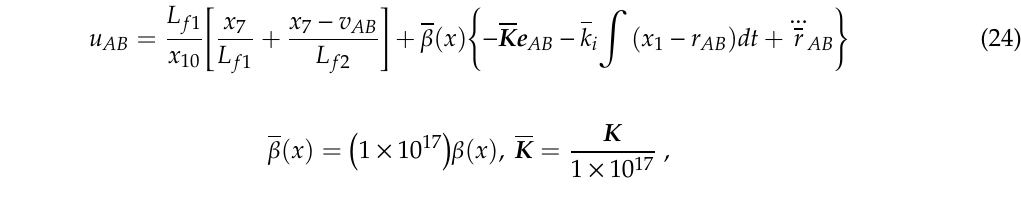
Figure 5. Procedure flowchart for the control law design. Table 2. Three-phase PWM rectifier requirements and parameters [34].